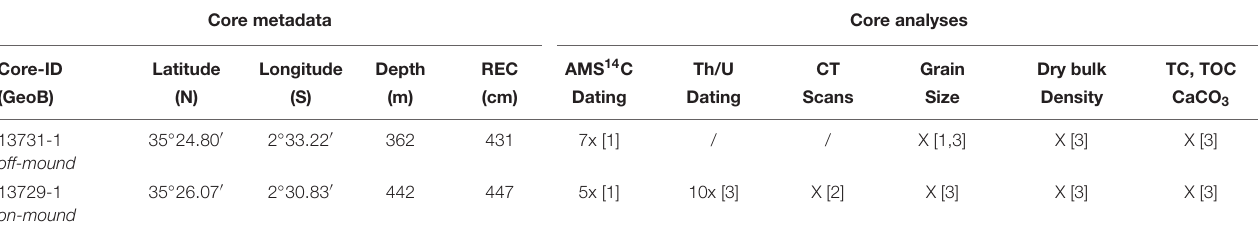
FIGURE 1 | (A) Overview map showing the Alborán Sea in the western Mediterranean. Coral mound provinces are indicated by a red triangle. (B) Bathymetry map of the northern East Melilla cold-water coral mound province in the southern Alborán Sea showing the locations of the sediment cores used for this study (off-mound: GeoB13731-1, on-mound: GeoB13729-1). Map modified from Hebbeln (2019). TABLE 1 | Metadata of gravity cores collected from the East Melilla coral mound province (southern Alborán Sea) during the cruise POS 385 with the German RV Poseidon in 2009 (Hebbeln et al., 2009). Indicated are also analyses which were applied to the core sediments. Some data of these analyses were previously published in Fink et al. (2013) and Titschack et al. (2016), while others were newly obtained for this study. REC: core recovery, CT: computer tomography, TC: total carbon, TOC: total organic carbon,